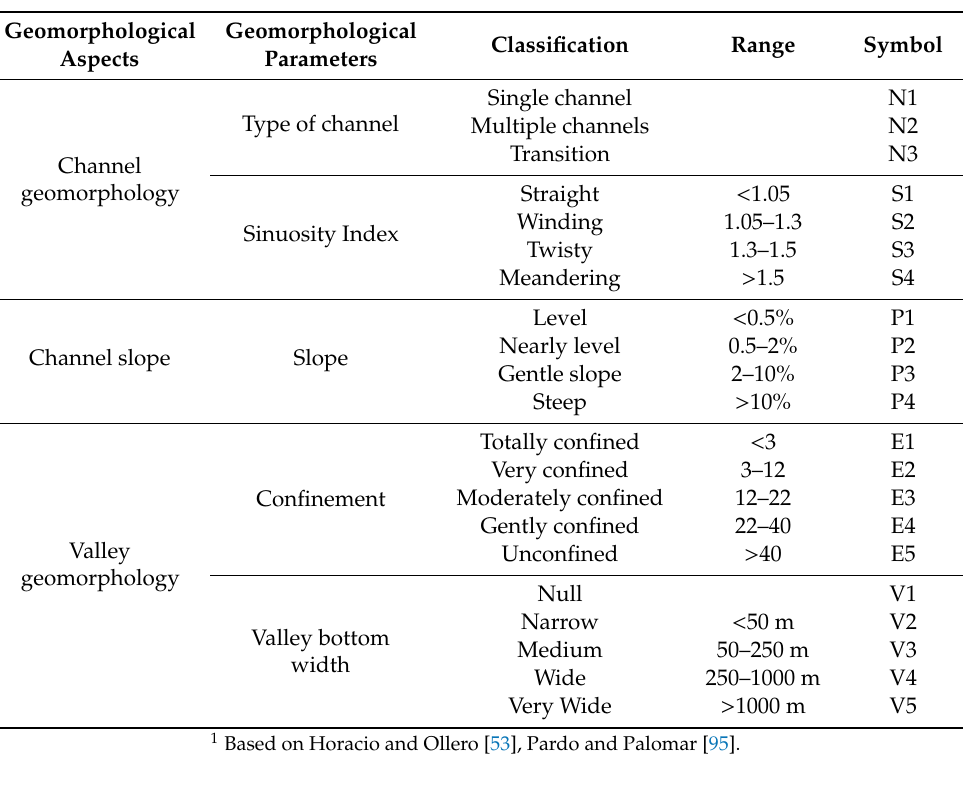
Table 2. Parameters and geomorphological aspects for river zoning and typification 1 .